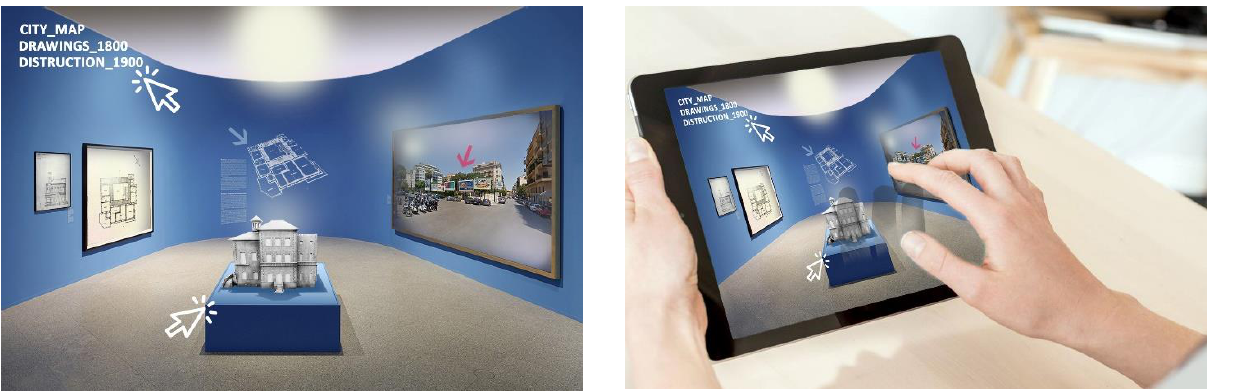
Figure 6. Virtual exhibition with different tasks about any possible thematic insight, personalized by users: the exhibition proposes the reconfiguration of a disappeared historic building (virtual exhibition by A.R.D. Accardi, 2019) Inspired by the variety of the contents of the database, the creative project could also include the subdivision into various themes, such as the architectural style, the social and cultural context, the history of the city and its evolution, its characters, the graphic representation and realization techniques of projects, etc., in an atmosphere of sensory experimentation to be experienced in this "exceptional" virtual context (Figure 6).